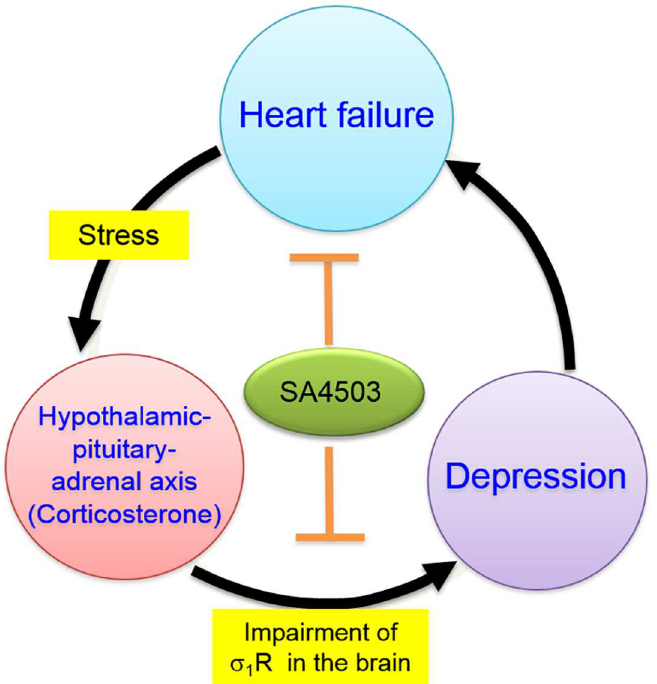
Fig 8. Schematic representation of the hypothesis tested and results obtained. Shown is a model depictingmechanisms underlyingTAC-induced depressive-like behavior, as suggestedby findings presented here. TAC-induced cardiac σ 1 R downregulation induces cardiac dysfunction. At the same time, levels of peripheral pro-inflammatory cytokines and corticosterone increase, aggravatingcardiac dysfunction and downregulating brain hippocampal σ 1 R levels. σ 1 R stimulation with SA4503 blocks TAC-induced σ 1 R downregulation in heart and in